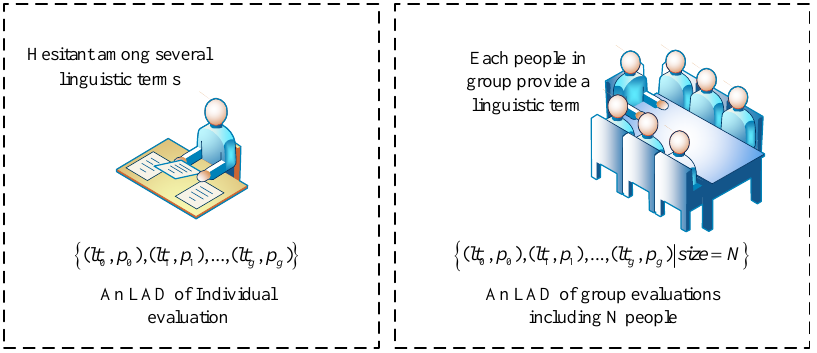
Figure 1. The difference between individual evaluation and group evaluation of LDA [15].